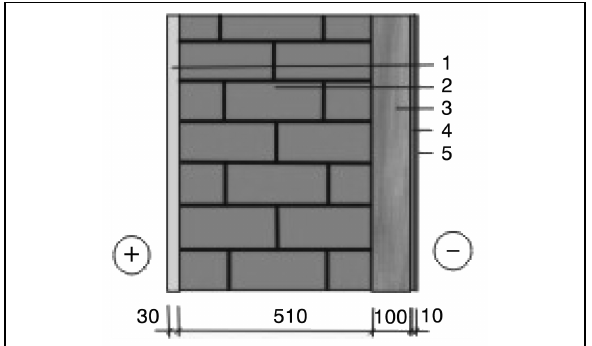
Fig 2. Wall construction: 1 – mineral render from inside; 2 – ce- ramic brick wall; 3 – mineral wool; 4 – thin mineral render;